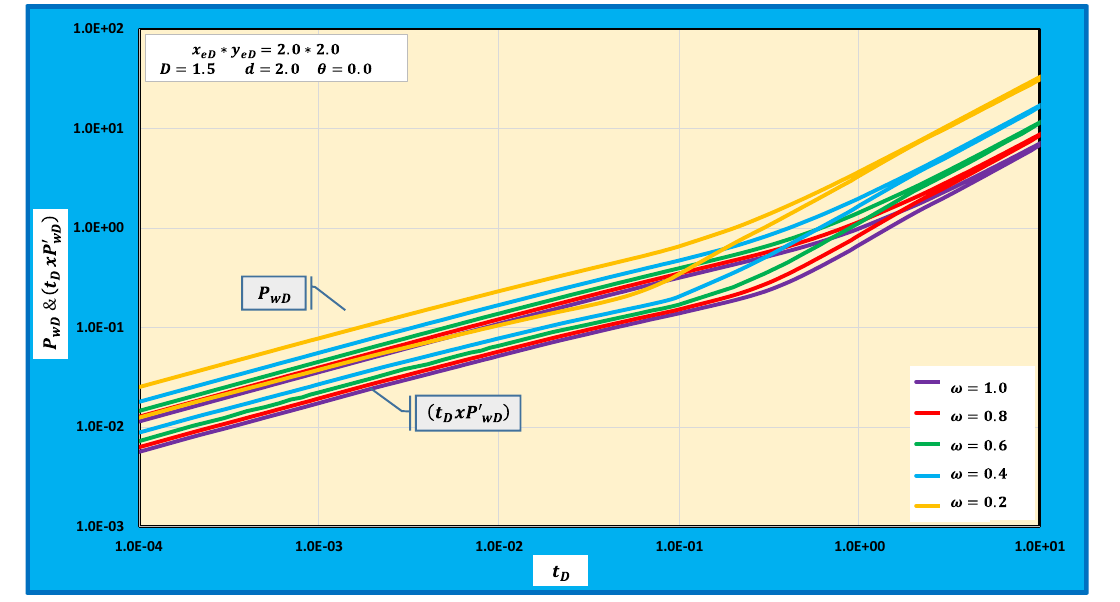
Fig. 11 Wellbore pressure and pressure derivative of different